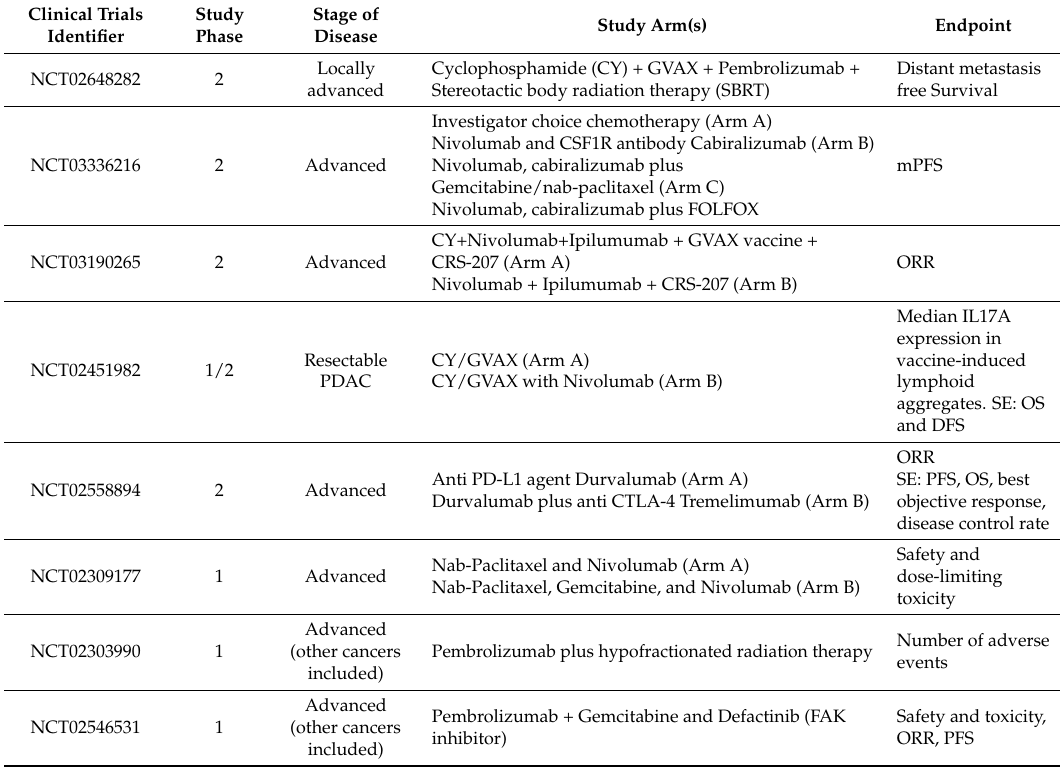
Table 3. Selected ongoing trials evaluating anti-PD-1/PD-L1 agents in advanced pancreatic cancer. Clinical Trials